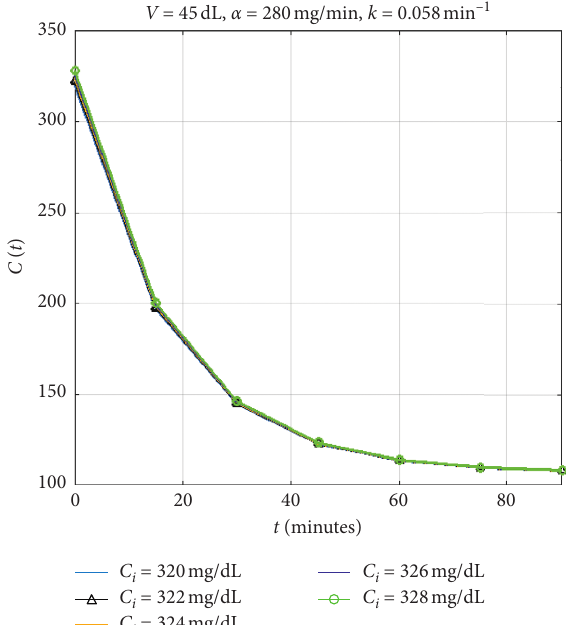
Figure 1: Blood glucose concentration C ( t ) for different values of initial concentration of glucose C i and time t with. V � 45dL , α � 280mg/min , and k � 0 . 058 min − 1 .